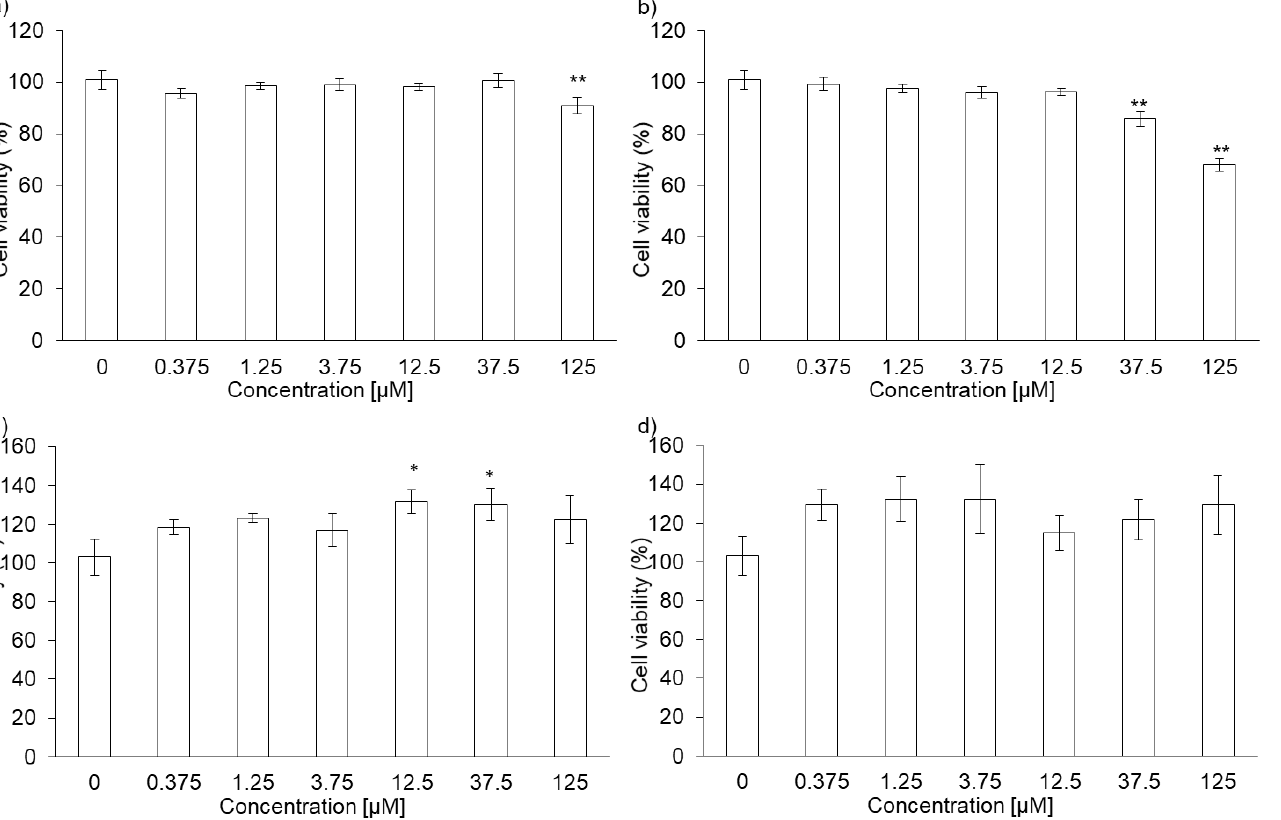
Figure 1. Cytotoxicity of PLP and laserphyrin. RGK1 ( a ) and RGM1 ( c ) cells were exposed to culture medium containing several concentrations of PLP. RGK1 ( b ) and RGM1 ( d ) cells were exposed to culture medium containing laserphyrin. Data are expressed as means ± SD ( n = 5). * p < 0.05, ** p <